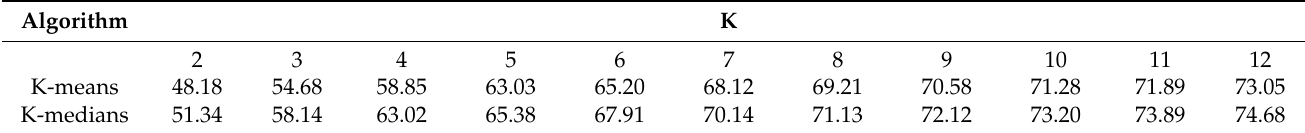
Table 3. Comparison of the AvgIOU (%) results from the two clustering method on the studs dataset.